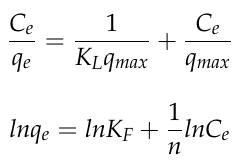
Figure 5. The selective adsorption of different adsorbents in mixed dyes.